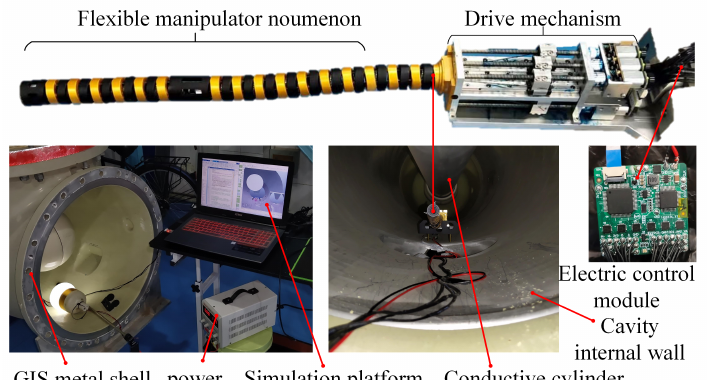
Figure 8. The prototype and experimental